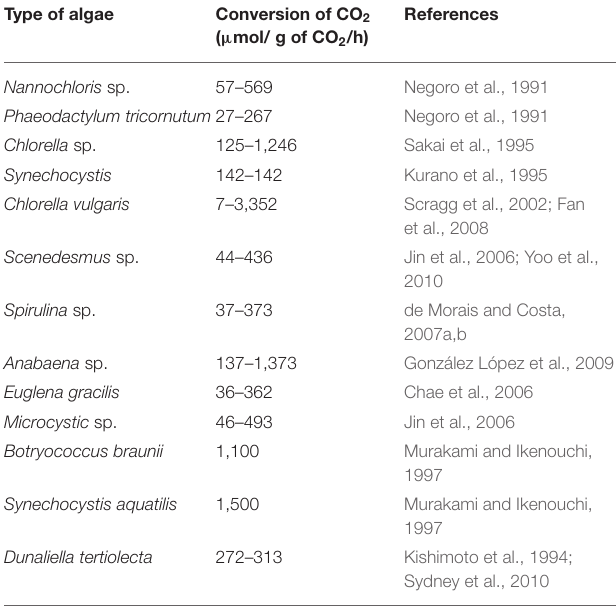
TABLE 3 | Summary of diverse algal species for CO 2 fixation and conversion